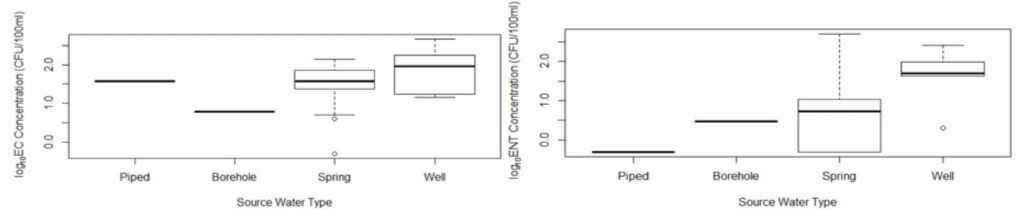
Figure A2. Boxplots of the log 10 -transformed concentrations of E. coli ( left ) and Enterococci ( right ) in household source water samples, stratified by type of source. The midline of the box represents the median of the data, with the upper and lower bounds of the box showing the first and third quartile. The whiskers show the extremes of the data that is within 1.5 times the interquartile range. Any data points outside this range are plotted as outlier